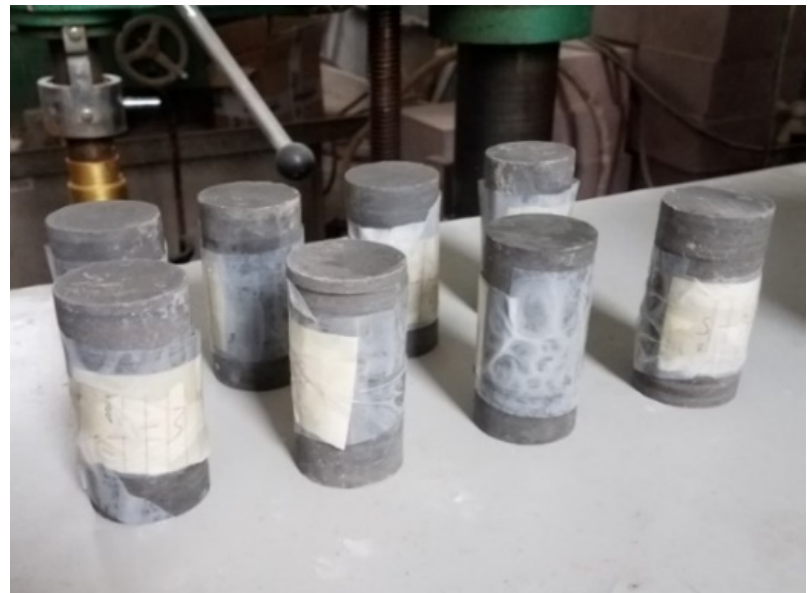
Figure 3. Test sample.